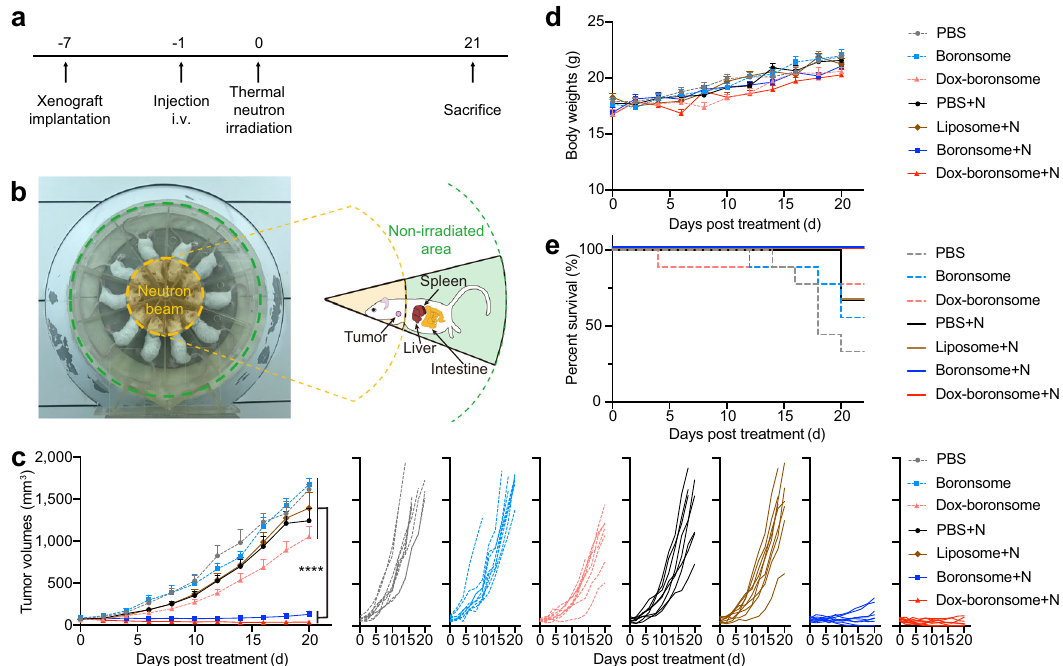
Fig. 5 Chemotherapy-assisted BNCT provided excellent suppression of tumour growth. a Experimental fl ow chart of treatment. b Photograph of thermal neutron beam and special-made mold at IHNI. Relative positions of main organs and tumours were shown in the sketch. c – e Female 4T1 tumour-bearing BALB/c mice of 6 – 8 weeks were intravenously injected with PBS, liposome, boronsome or Dox-boronsome, several groups were irradiated with thermal neutrons ( + N). c Average tumour volumes ( n = 9) of each group of mice (One-way ANOVA test with Tukey ’ s multiple comparisons test for data of 20 days post treatment, **** p < 0.001). d Average body weights ( n = 9) of each group of mice. e Survival fractions ( n = 9) of each group of mice. Source data are provided as a Source Data fi